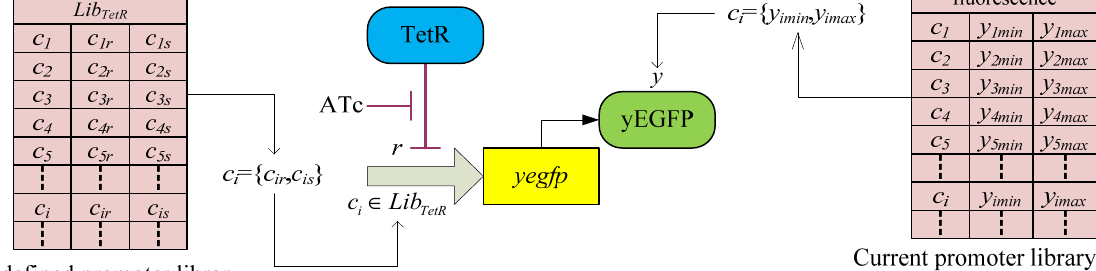
Figure 10. Single schematic diagram of the synthetic promoter-regulation gene circuit. The existing TetR-regulated promoter library contains the minimum and maximum values of fluorescence [ y , y ] corresponding to with and without TetR (repressor) binding. Based imin imax on the promoter regulation function (3.21) and these values, the promoter library is redefined for the design of synthetic gene networks (Table